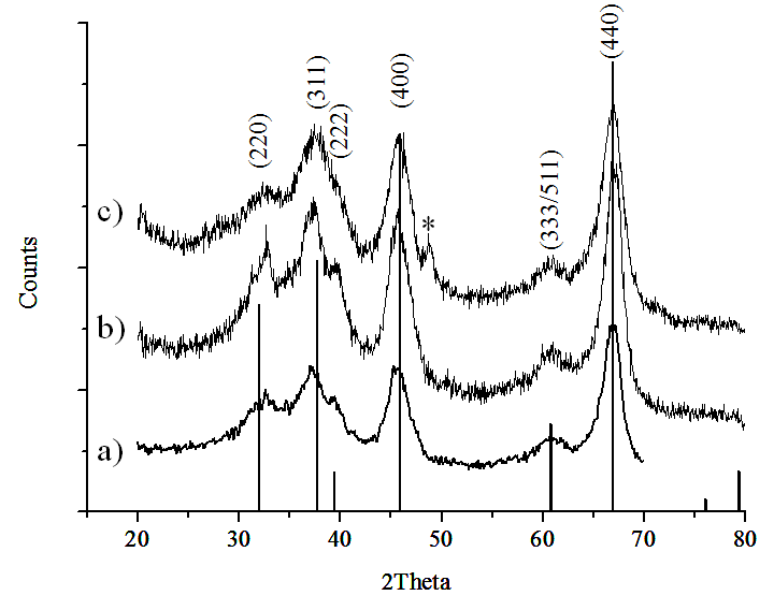
Figure 1. X-ray diffraction (XRD) patterns of commercial γ-Al 2 O 3 nanoparticles (NPs) in size of: ( a ) 5